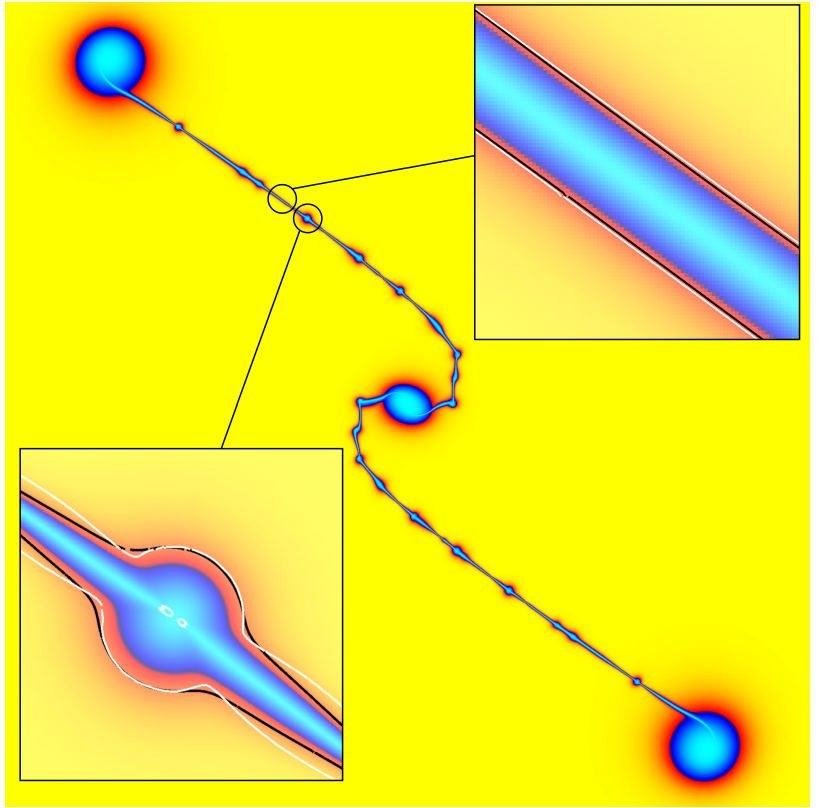
Figure 4 . Last time slice shown in figure 1 for the 7 D collision at ∆ t = 32 . 75 . We zoom into two different regions of the thinnest part of the geometry. In the string-like region (upper right inset) we show the χ = 0 . 6 contour as a black line, and the ˜ K | = 1 contour in white. In the region near χ 0 =0 . 6 a satellite (lower left inset) we show the contours χ = 0 . 7 in black and the ˜ K | = 5 / 2 contour χ 0 =0 . 7 in white. The fact that these contours are in very good agreement indicates that the contours of χ = 0 . 6 , 0 . 7 track the horizons of string-like and spherical-like portions of the geometry respectively. Furthermore, the unnormalized Kretschmann scalar diverges ∝ W − 4 , where W is the proper width of the neck-like regions of the